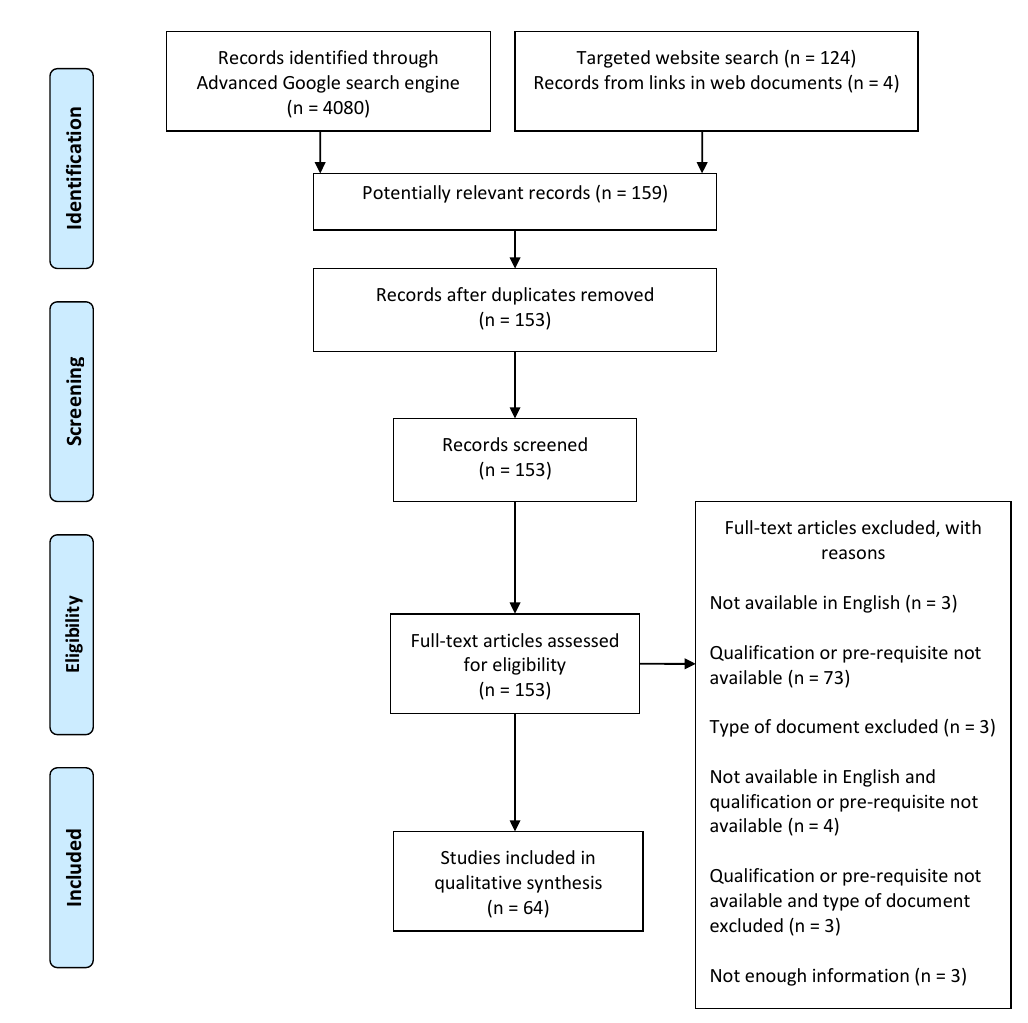
Figure 1. PRISMA flow diagram of the review. Table 1. Minimum qualification required to practise as a recognised midwife.